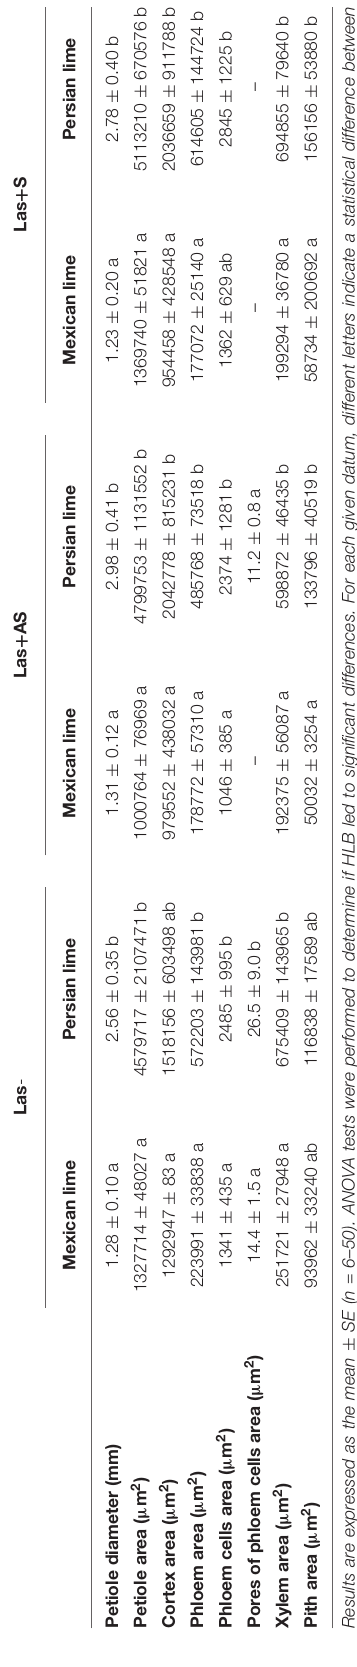
To verify whether the differences between Mexican lime and Persian lime cultivars could be explained by different levels of intercellular sieve pore plugging, we performed SEM on petiole control samples. Phloem cells and sieve plate pores of Persian lime trees were larger than those of Mexican lime trees.